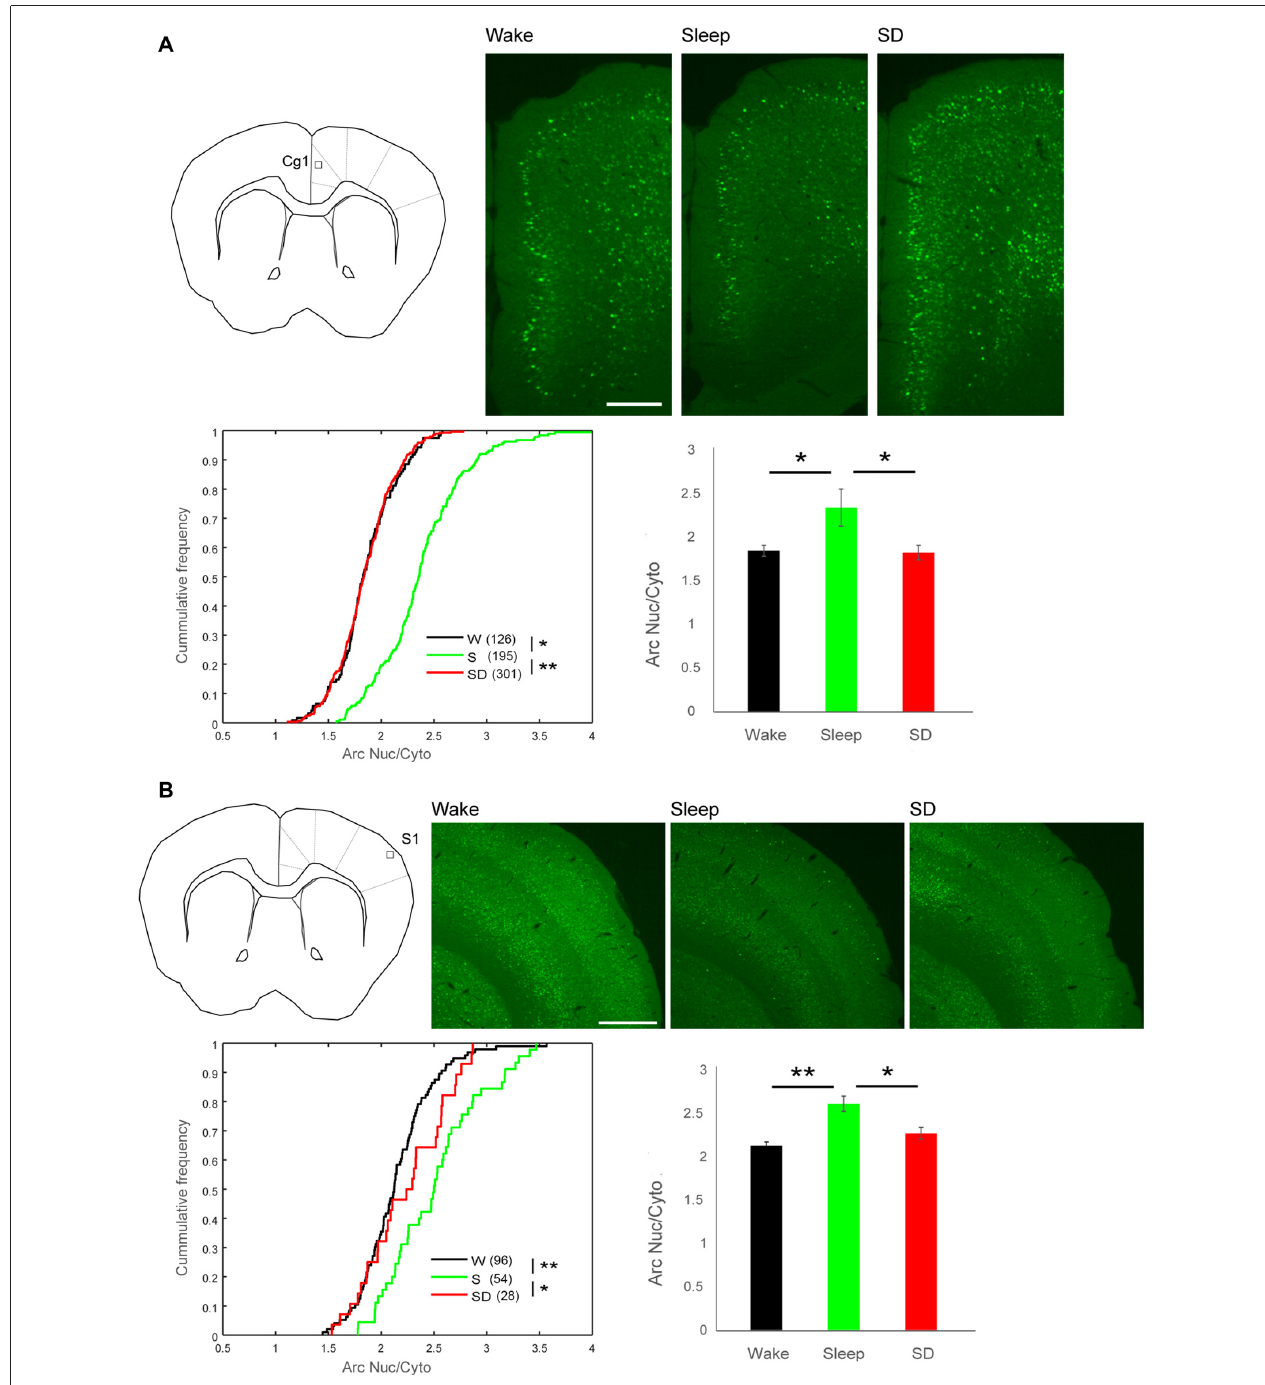
FIGURE 3 | Arc Nuc/Cyto in superficial layers of cingulate cortex area 1 (Cg1) and primary somatosensory cortex (S1). (A) Top left, schematic representation of imaging field in superficial layers of Cg1. Top right, examples of EGFP-Arc expression in each group. Scale bar = 0.25 mm. Bottom left, cumulative frequency plots of Arc Nuc/Cyto in High Arc neurons in superficial layers of Cg1 (number of cells in parenthesis) ∗ p = 2.47–22, ∗∗ p = 9.23e-37, two-sample Kolmogorov-Smirnov test using Arc Nuc/Cyto ratio of all analyzed neurons. Right, mean and standard deviation ( W = 4 mice, S = 6, SD = 6). ∗ p < 0.01, unpaired t -test using mean value of each mouse. (B) Top left, schematic representation of imaging field in superficial layers of S1. Top right, examples of EGFP-Arc expression in each group in S1. Scale bar = 0.5 mm. Bottom left, cumulative frequency plots of Arc Nuc/Cyto in High Arc neurons in superficial layers of S1 (number of cells in parenthesis). ∗ p = 0.0087, ∗∗ p = 4.00e-07, unpaired t -test using Arc Nuc/Cyto ratio of all analyzed neurons. Right, mean and standard deviation ( W = 4 mice, S = 6, SD = 6). ∗ p < 0.05, ∗∗ p < 0.01, unpaired t -test using mean value of each mouse.